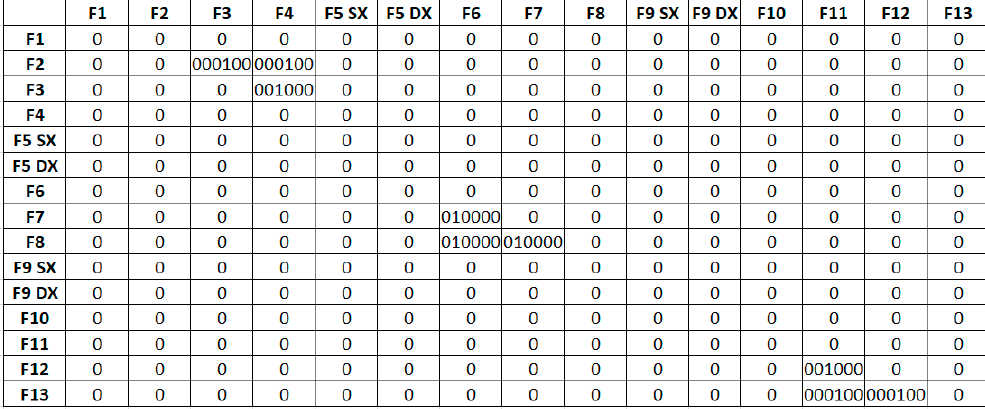
Figure 18. FFM (fasteners fasteners matrix).